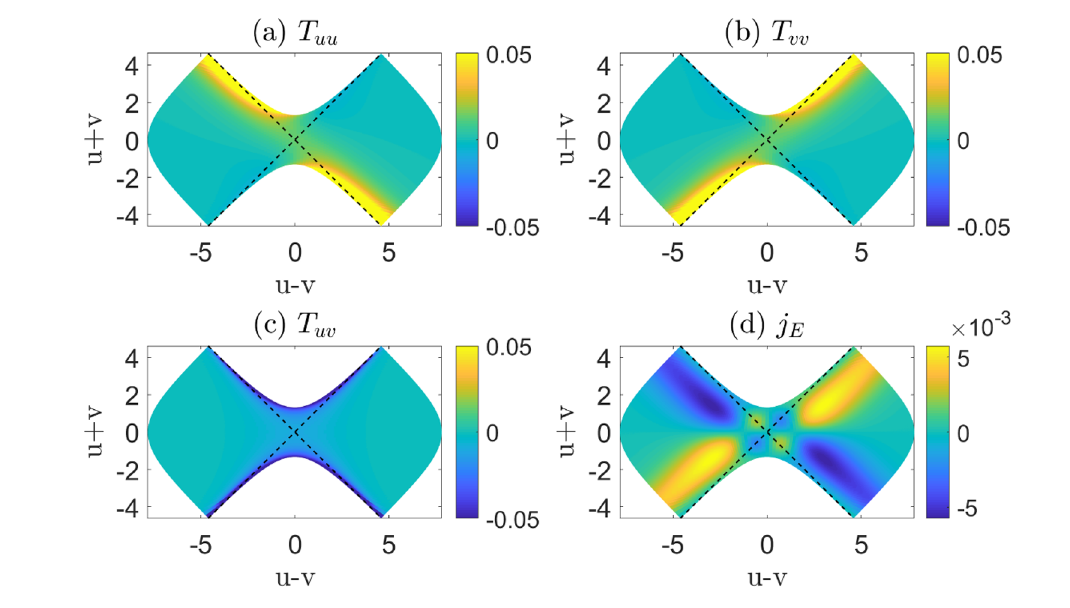
Figure 11. (a)-(c) Numerical results of the three components of energy momentum tensor. T uu and T vv peaks around the horizon, and T uv is slowly varying in most of the places. Divergence occurs near singularity. (d) The outgoing energy current density across a constant r surface, given by eq. (3.34). (Note that the scale is smaller than (cid:12)gure (a)-(c). We plotted this quantity